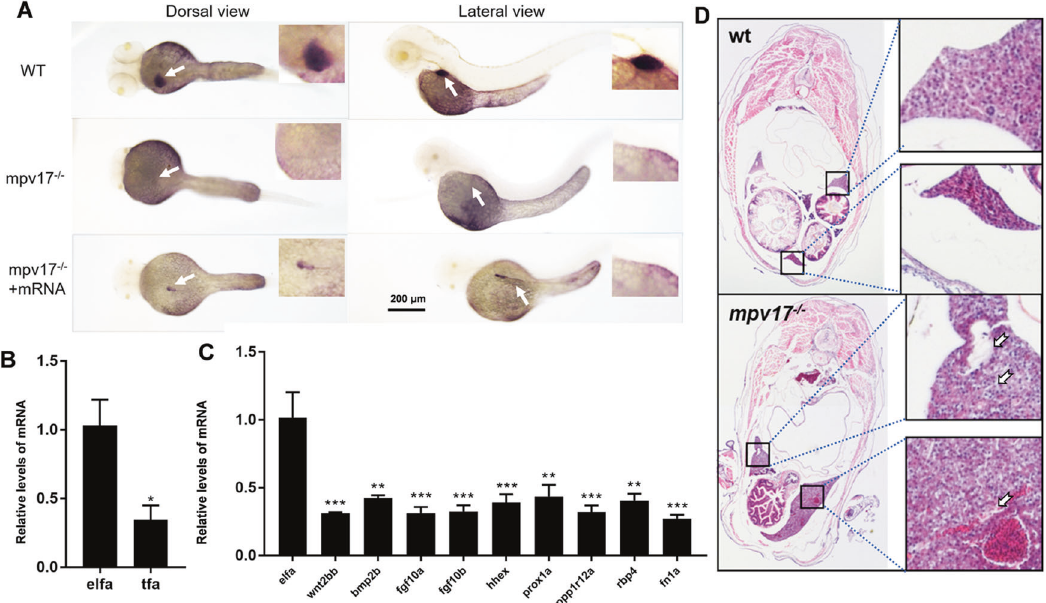
Fig. 5 The development of the liver was abnormal in the mpv17 − / − zebra fi sh. A In situ hybridization with RNA probe tfa at 3 dpf. Wild-type was in the upper, mpv17 − / − in the middle, and the lower was the mpv17 − / − larvae rescued with mpv17 mRNA. B In situ hybridization of larvae at 5 dpf using tfa probe. C The expression level of genes tfa . Error bars were indicated with ±SEM, * p < 0.05. D The expression levels of genes involved in liver development. Error bars were indicated with ±SEM, ** p < 0.01, *** p < 0.005. E H&E staining paraf fi n-embedded sections of the liver in 1-month-old zebra fi sh. The black frames were enlarged as shown on the right.